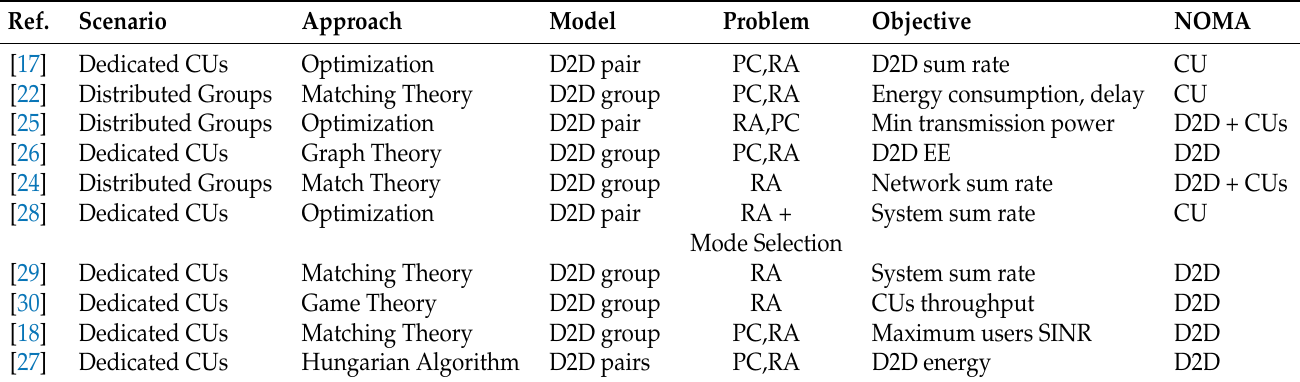
Table 1. D2D pair/groups, MD2D and NOMA: State of the